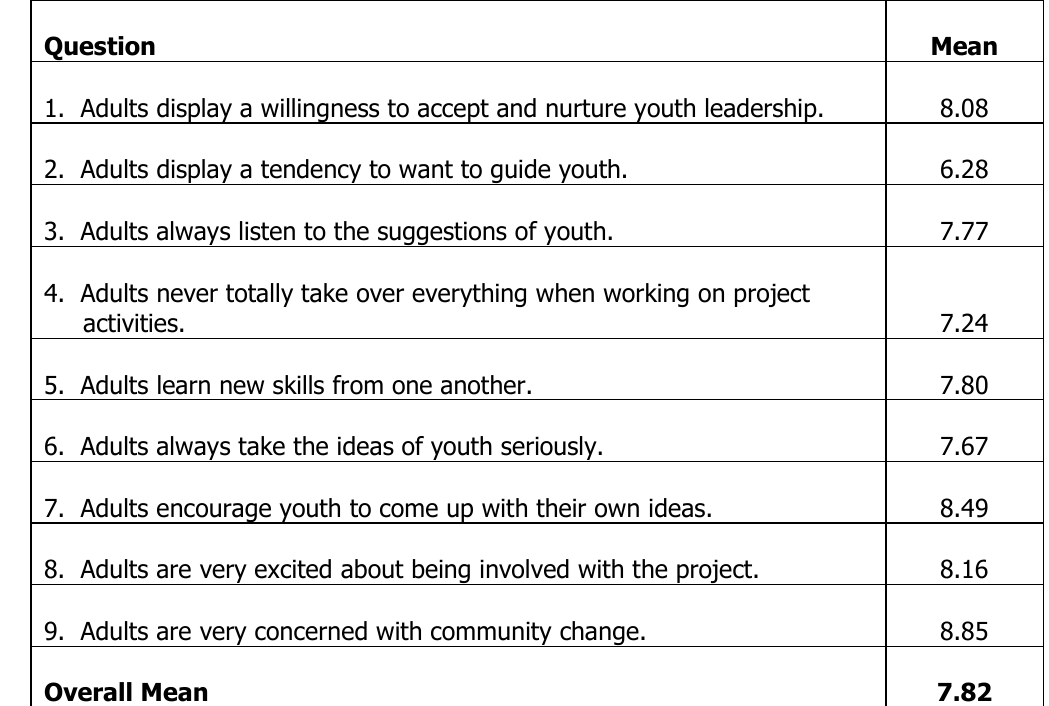
Youth Board youth only members adult involvement indicators